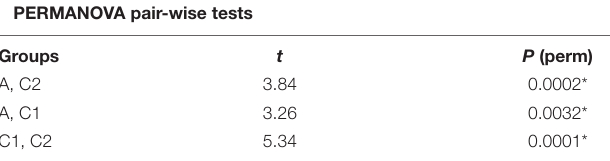
TABLE 2 | PERMANOVA